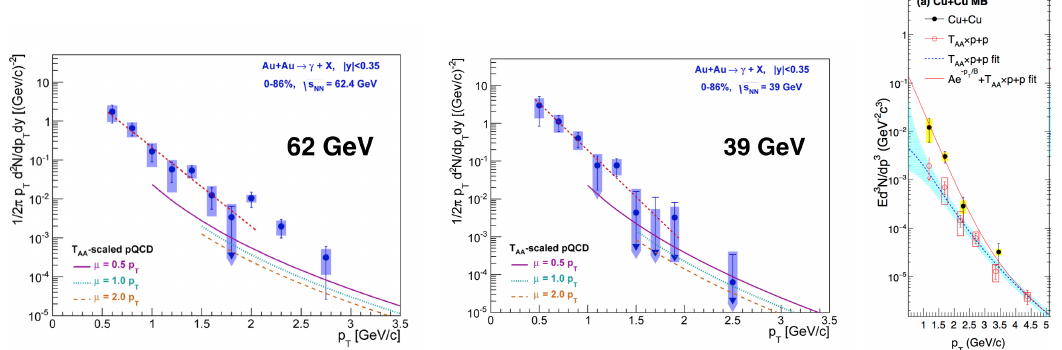
√ s NN = 62.4 GeV ( left ), Au+Au √ s NN = 200 GeV ( right )